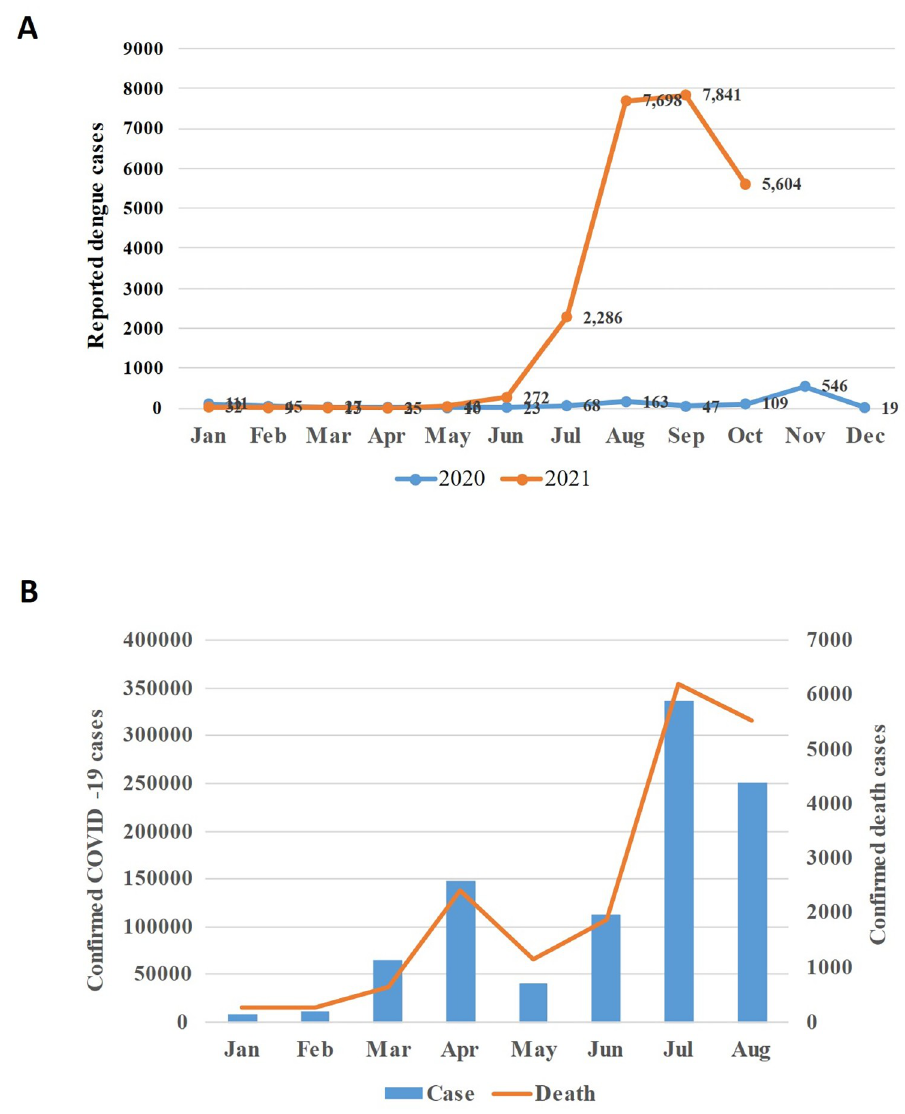
Fig 1. Trend of dengue and COVID-19 case reporting. (A) Number month-wise hospitalized dengue cases 2020 and 2021. (B) Number of confirmed COVID-19 cases by months in 2021. COVID-19, Coronavirus Disease